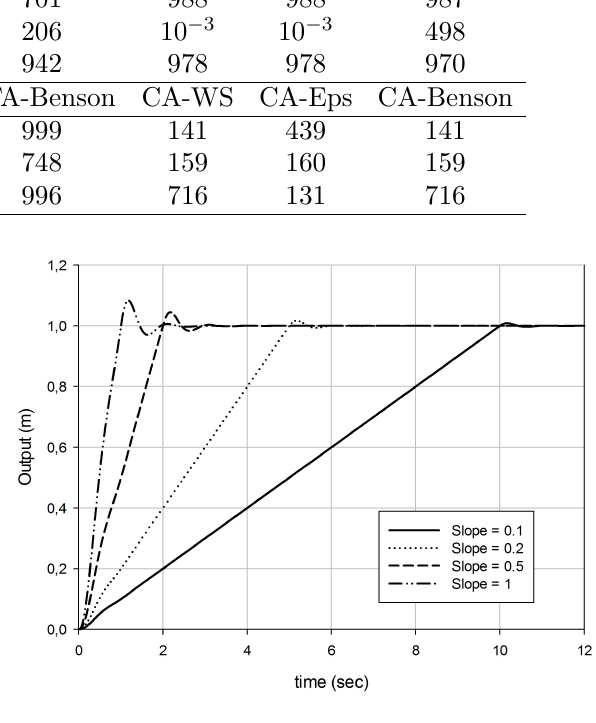
Table 2. PID controller parameters, where WS: Weighted Sum, and Eps: Epsilon. PID Parameters PSO-WS PSO-Eps PSO-Benson